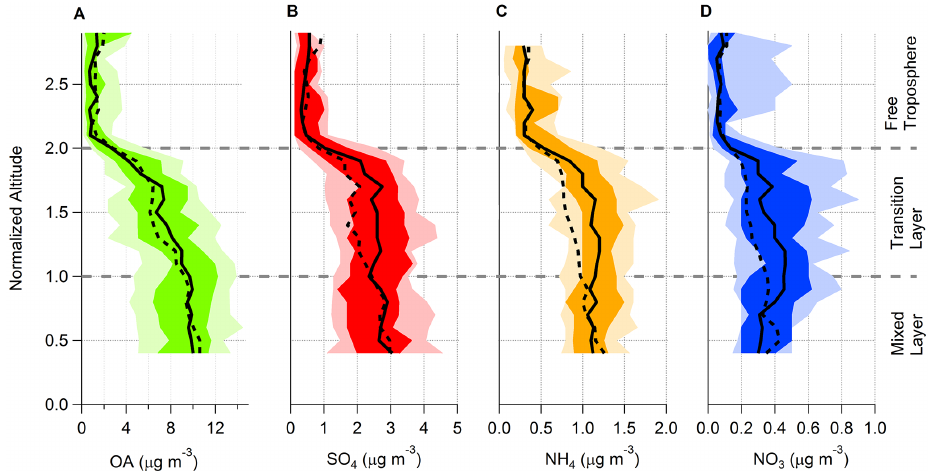
Figure 10. Altitude-normalized profiles of the aerosol composition: (a) OA, (b) SO 4 , (c) NH 4 , and (d) NO 3 . The shaded regions show the interdecile range (light) and the interquartile range (medium), and the solid lines are the median (dark). The dashed line shows the median expected concentration from vertical mixing alone (Eq.